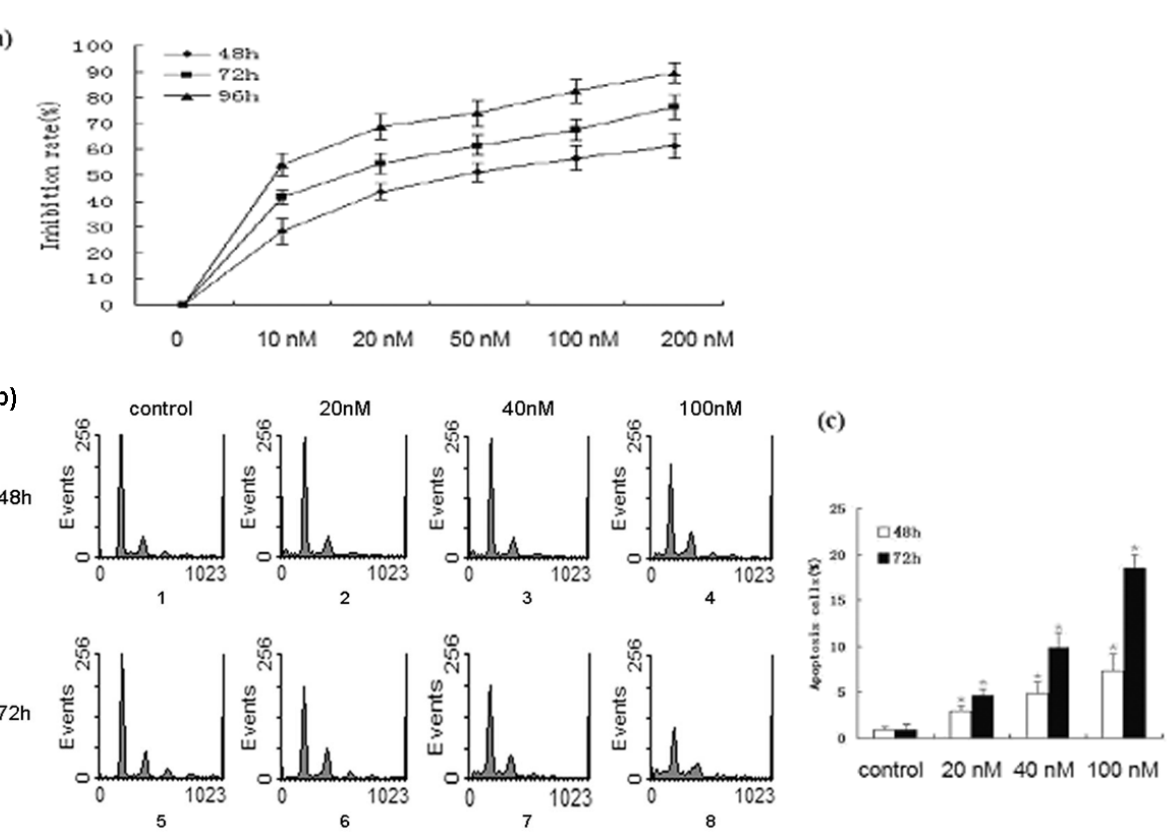
Figure 1. Bufalin inhibits the proliferation and induces the apoptosis of A549